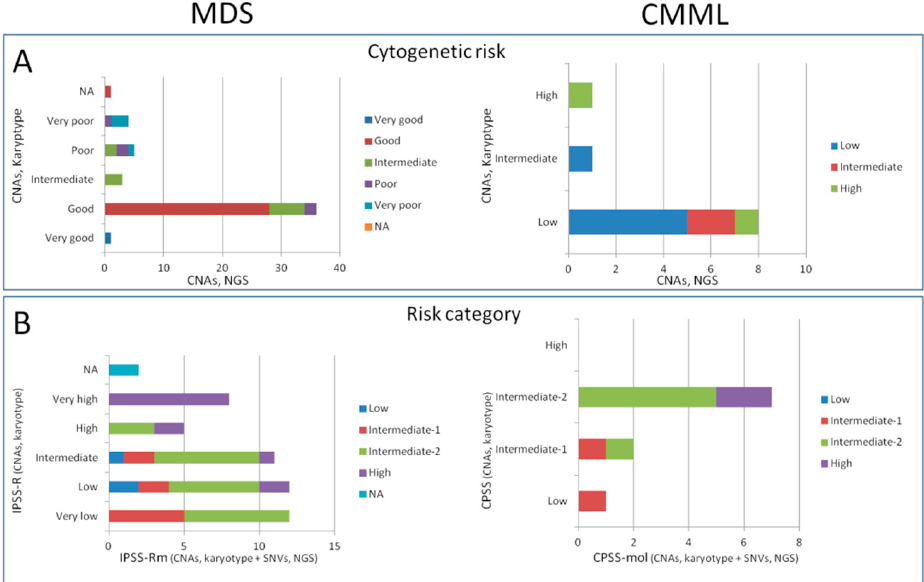
Figure 4. Distribution of changes in cytogenetic risk ( A ) and risk categories ( B ) across the original and molecular versions of IPSS-R and CPSS models when the results of NGS were used instead of conventional cytogenetics. This diagram shows the changes observed (upstage or downstage) across all considered models. The Y axis represents the original cytogenetic risk and risk category in the charts at the top ( A ) and at the bottom ( B ), respectively. The X axis represents the percentage of patients in each risk category found through the use of NGS. For example, among MDS patients with good cytogenetic risk according to conventional cytogenetics, ~78% still remain in this category, whereas 17% and 5% shift to intermediate and poor risk, respectively, when results from NGS are used. Abbreviations: NA, not available; CNAs, copy number alterations; SNVs, sin- gle-nucleotide variants; NGS, next-generation sequencing. IPSS-R, Revised International Prognos- tic Scoring System; IPSS-R, molecular IPSS-R; CPSS, CMML-specific prognostic scoring system, CPSS-mol, molecular CPSS.